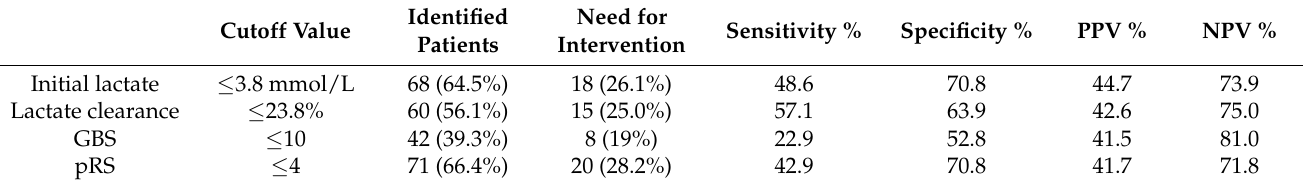
Table 3. Sensitivity, specificity, PPV, NPV of analyzed pre-endoscopic risk assessment tools for predicting need for intervention, using the cutoff with the highest sum of sensitivity and